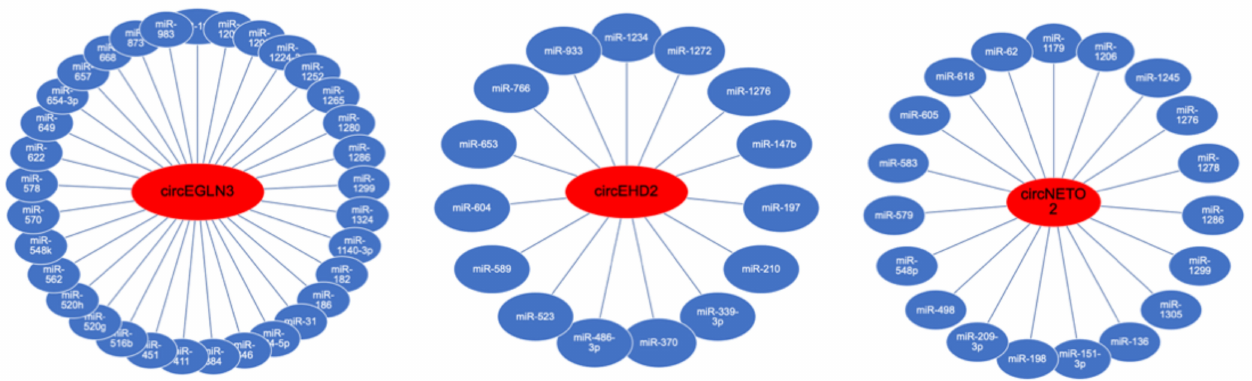
Figure 4. The circRNAs circEHD2, circEGLN3, and circNETO2 have several putative RNA-binding protein binding sites in circRNA junction and the 5 (cid:48) -flanking sites.